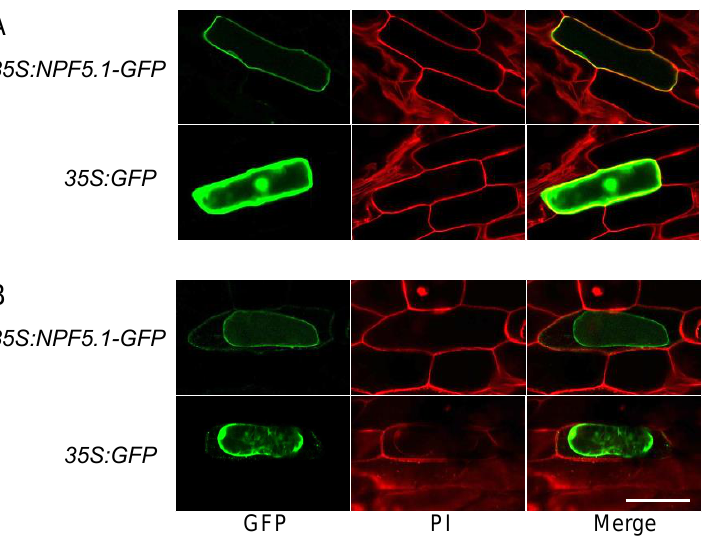
Figure 6. Plasma membrane localization of NPF5.1. GFP signals in onion epidermal cells that transiently express GFP-fused NPF5.1 or GFP alone under the control of the 35S promoter ( 35S:NPF5.1- GFP and 35S:GFP , respectively). Photos were taken before ( A ) and after ( B ) plasmolysis with 20% mannitol. PI indicates propidium iodide staining of the cell walls. Scale bar = 200 µ